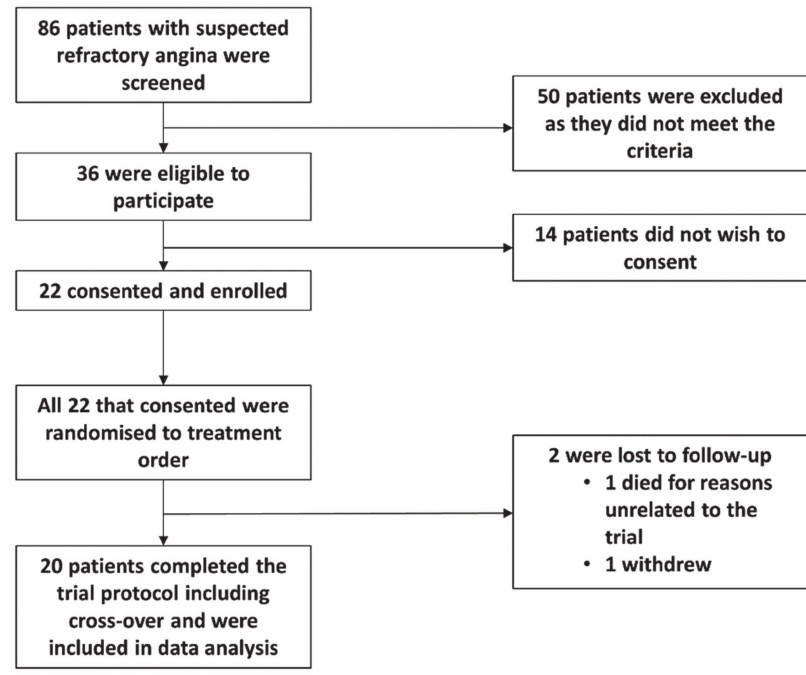
Figure 2. CONSORT flow